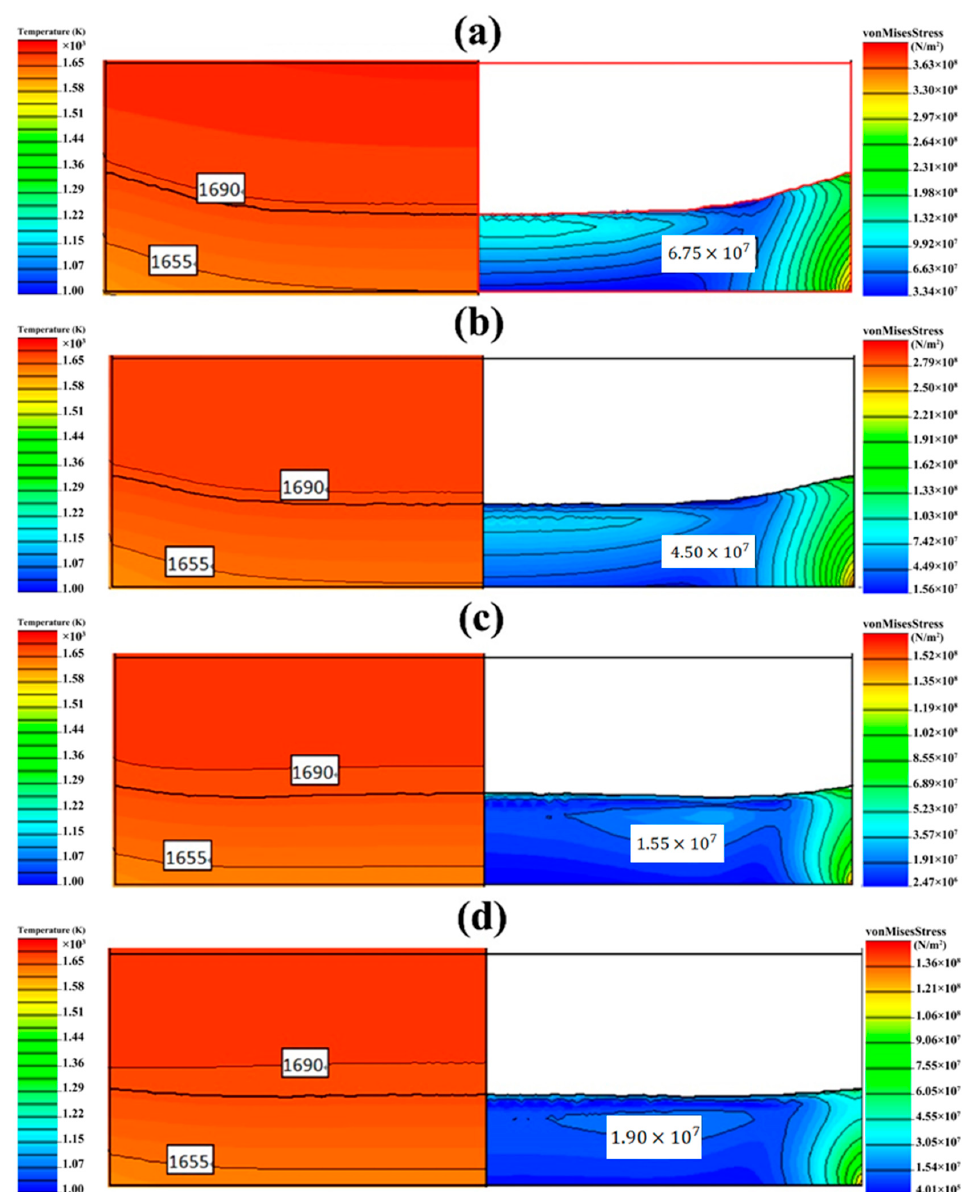
Figure 3. Temperature distribution and thermal stresses for the di ff erent power ratios at the half stage: ( a ) 1:1, ( b ) 1:2, ( c ) 1:3, and ( d )